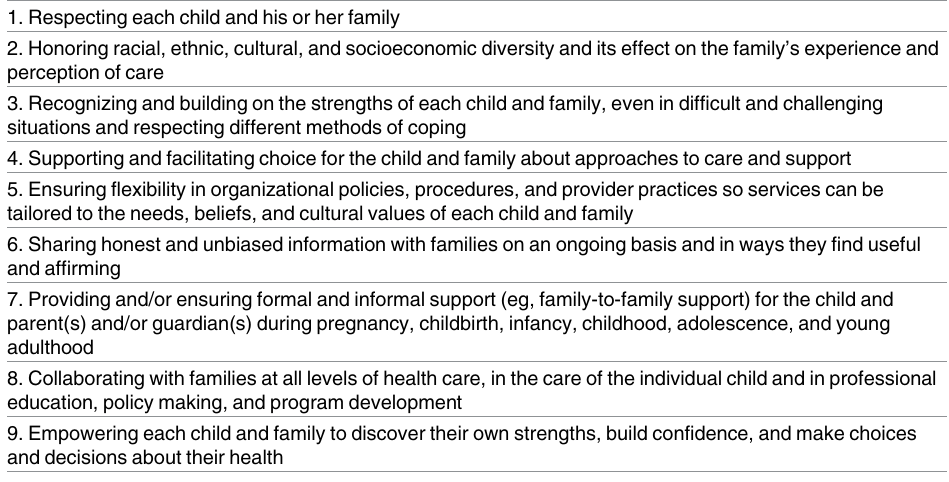
Table 1. Core principles of family-centered care according to the AmericanAcademyof